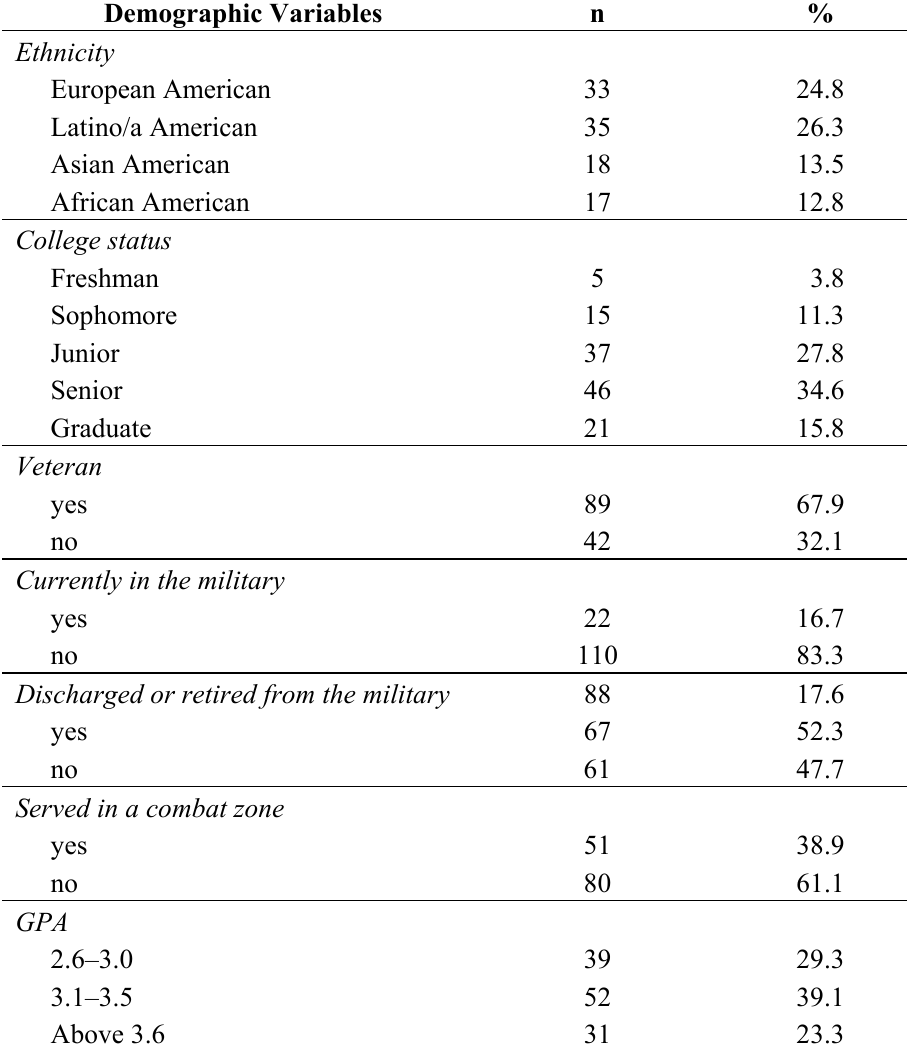
Table 1. Characteristics of the Sample (N =